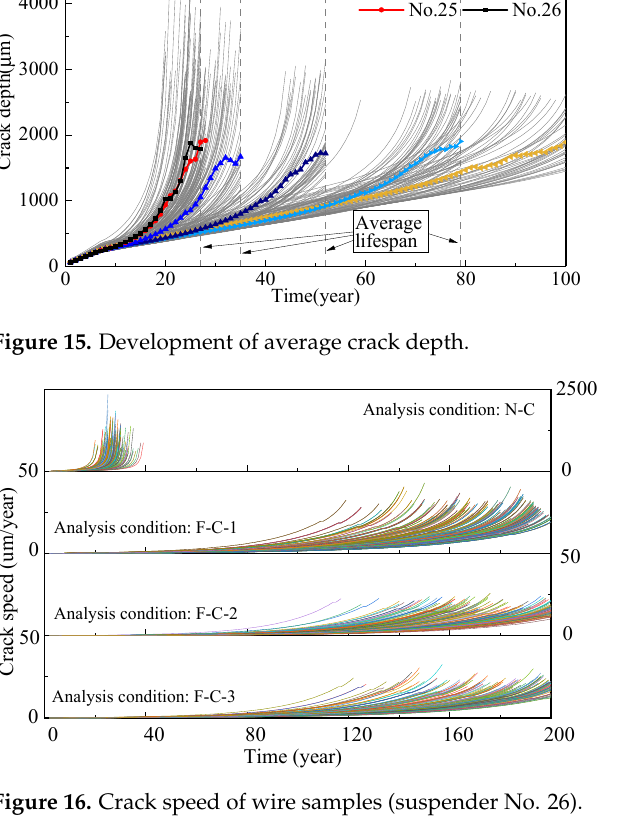
Table 4. Fatigue life of suspender wire under different analysis conditions. Suspender Number (Length)